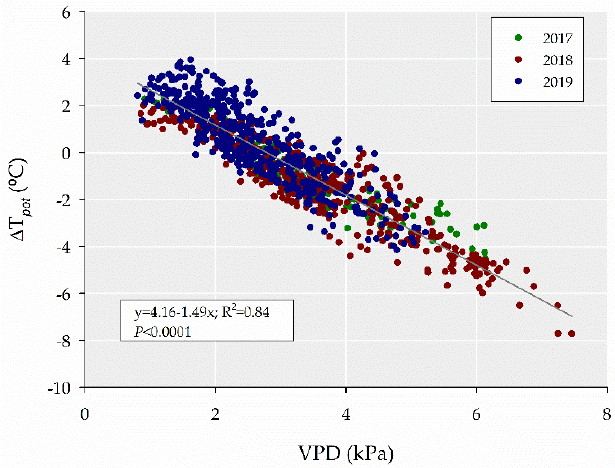
Figure 2. Relationship between canopy-to-air temperature difference of well-watered maize plants ( ∆ T pot ) and vapor pressure deficit (VPD). Data from the time interval 10–17 UTC and from three growing seasons (2017, 2018, 2019) are pooled together. Each point represents a single maize breeding plot. The straight line is the best-fit regression line.